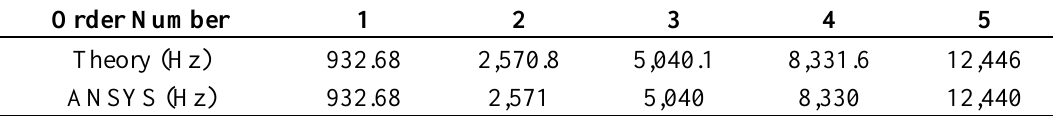
Table 1. Fifth order natural frequencies of guideway